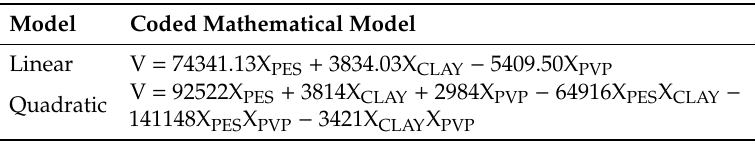
Table 4. Coded mathematical models: linear and quadratic for viscosity.